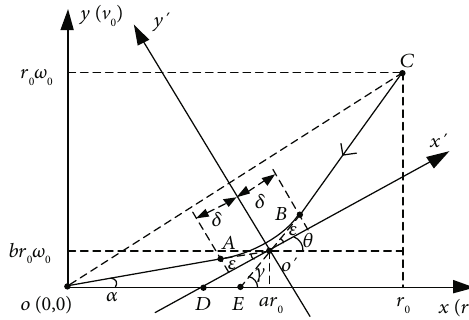
Figure 3: Standard tracking pro fi le of v